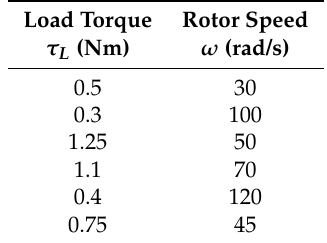
Table 1. Operation conditions for off-line